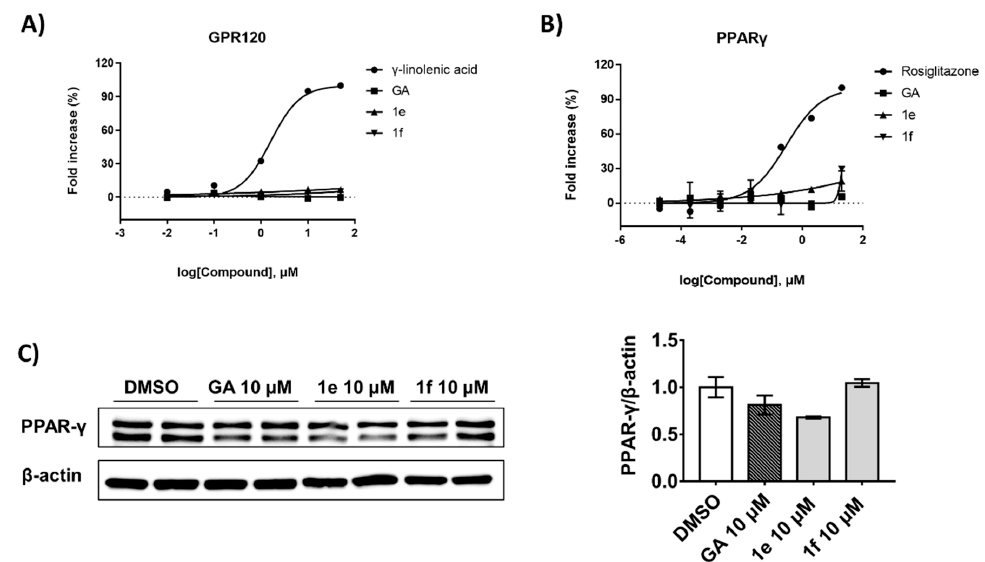
activity. Transcriptional activity was determined in CHO cells transiently co-transfected with the GPR120 plasmid and the luciferase reporter, SRE-Luc ( A ), or with PPAR γ and PPRE-Luc ( B ). Three hours following transfection, the cells were treated with indicated concentrations of the compounds for an additional twenty − four hours. Here, γ -linolenic acid ( A ) or rosiglitazone ( B ) was used as the positive control. ( C ) Immunoblot analysis of PPAR γ levels in 3T3-L1 adipocytes following treatment with GA and 1e at the indicated concentrations. The densities of corresponding bands were quantified using the ATTO CS Analyzer 4 and normalized to that of β -actin. Data are presented as mean ± standard deviation ( n =